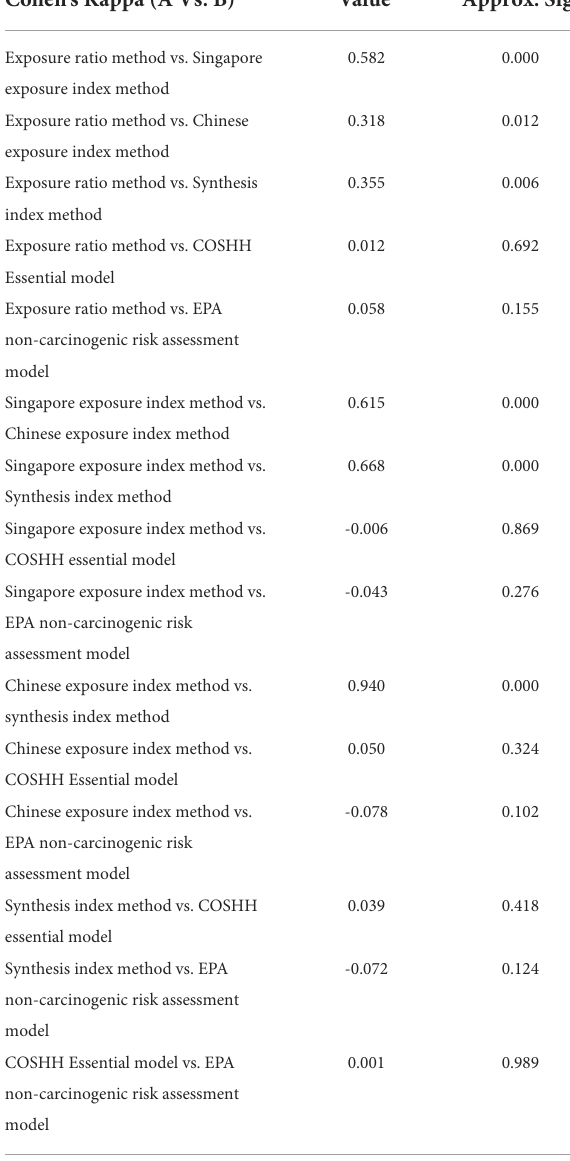
TABLE 5 Cohen’s Kappa results of risk assessment models of n-Hexane. Cohen’s Kappa (A Vs. B) Value Approx.